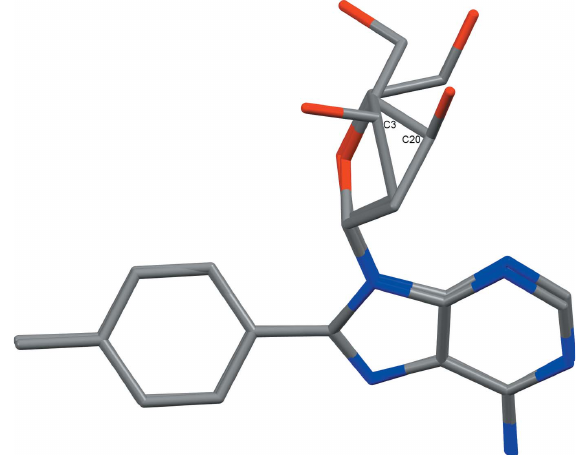
Figure 2 The two crystallographically independent molecules of the asymmetric unit overlaid. The root-mean-square deviation (rmsd) and the maximum distance between atom positions are 0.8296 and 2.6760 A˚ ,